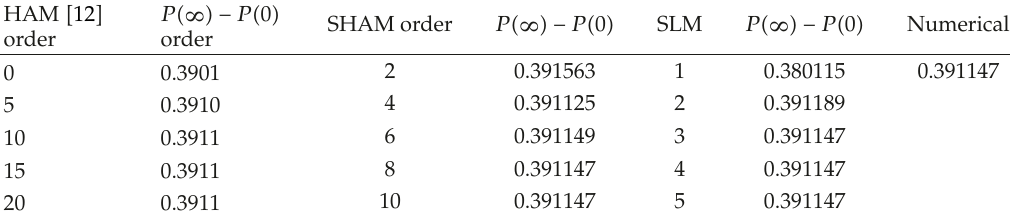
Table 2: Comparison of P (cid:6) ∞ (cid:7) − P (cid:6) 0 (cid:7) obtained at di ff erent orders for the HAM (cid:3) 12 (cid:4) , SHAM, and SLM approximations when (cid:2) (cid:10) − 1, L (cid:10) 20, and N (cid:10) 60.